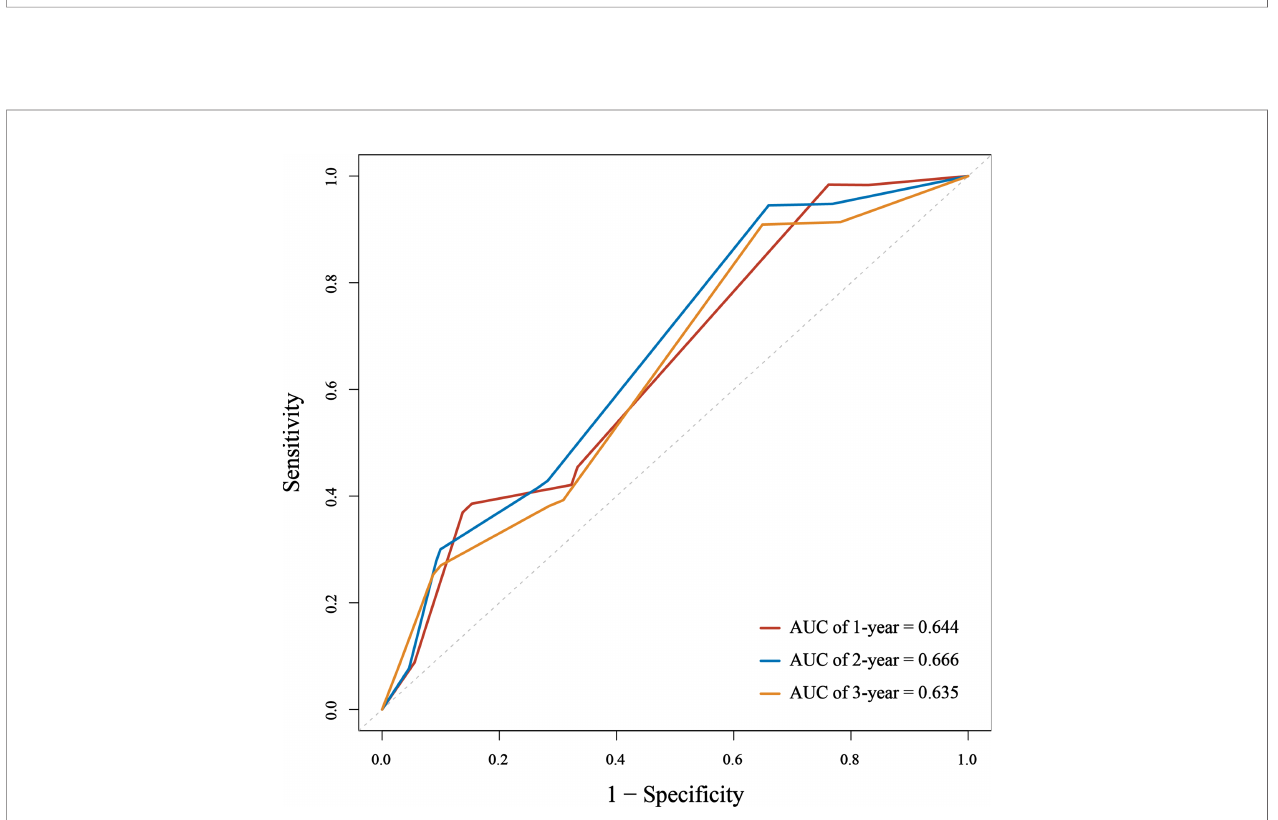
FIGURE 2 | Forest plot depicting the hazard ratios (HRs) of low-Risk and high-Risk in the subgroup analysis of overall survival (OS). ECOG, Eastern Cooperative Oncology Group performance score; CT cycles, chemotherapy cycles; PCI, prophylactic cranial